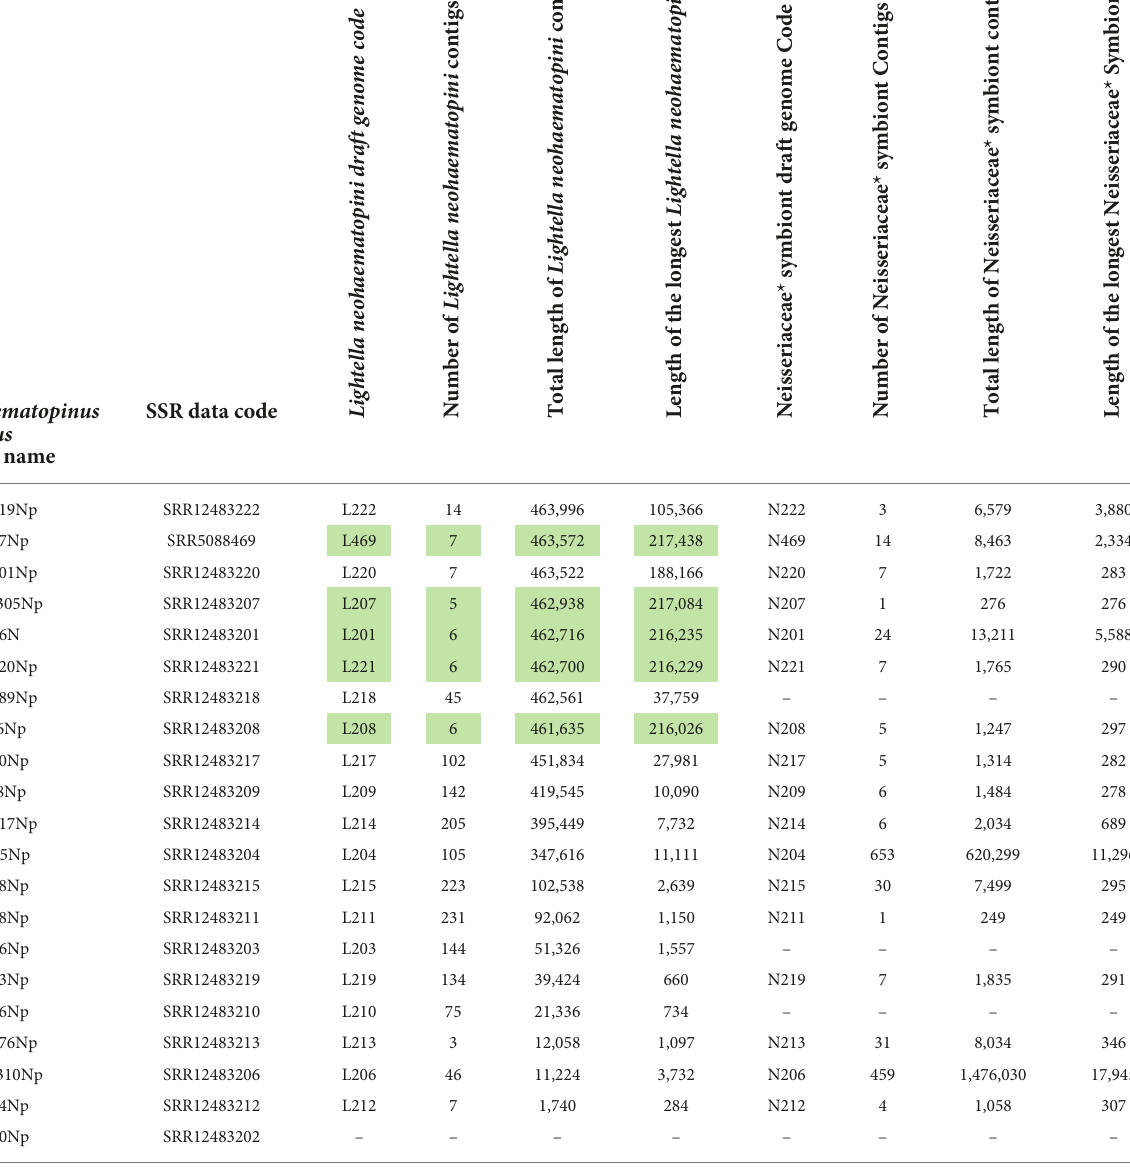
Neohaematopinus